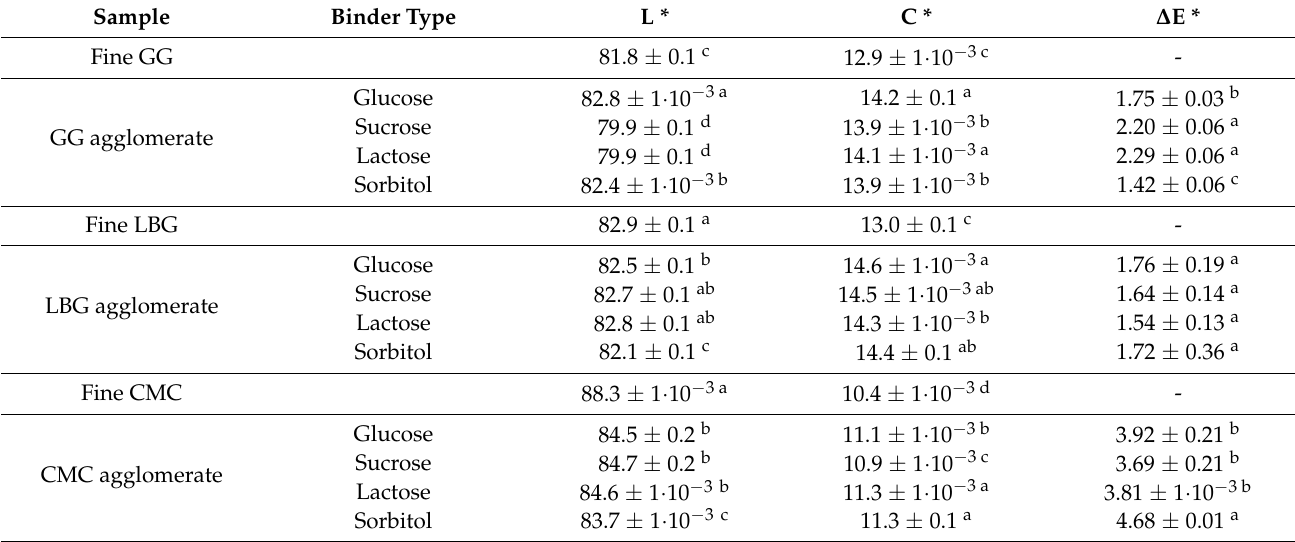
Table 4. Color parameters of fine gum powders and gum agglomerates (GG, LBG, and CMC) with different sugar binders.